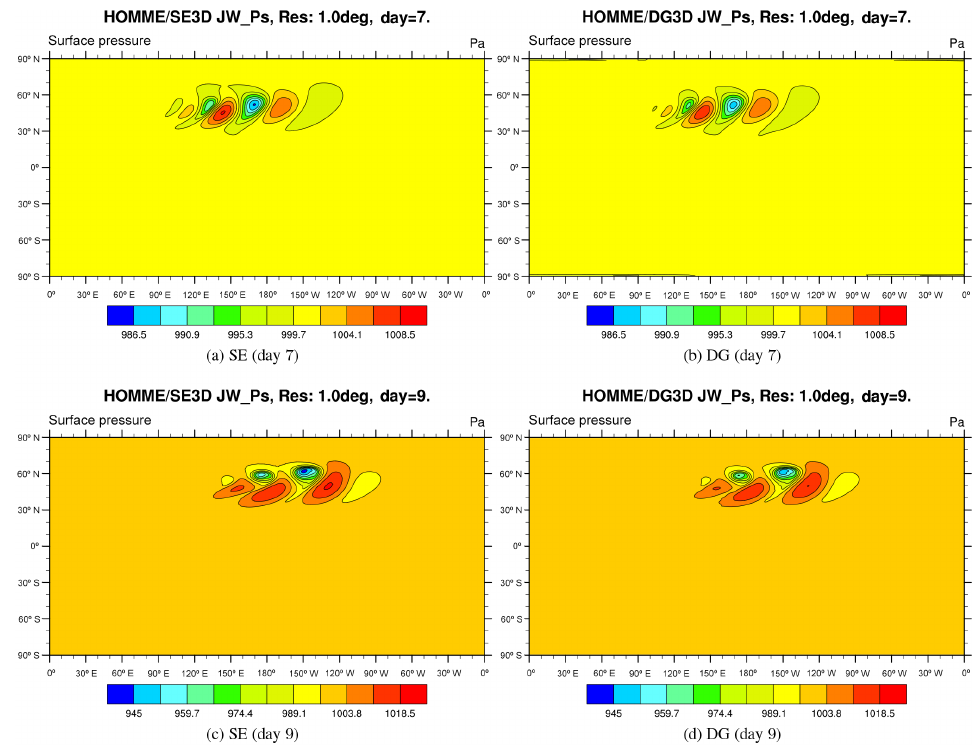
Figure 3. Surface pressure at day 7 and 9 for the HOMME-SE (a, c) and HOMME-DG (b, d) code for the Jablonowski–Williamson baroclinic wave instability test case. Both methods used 1 ◦ resolution at the Equator (nlev = 26; SE: np = 4, n e = 30; DG: np = 6, n e = 18).